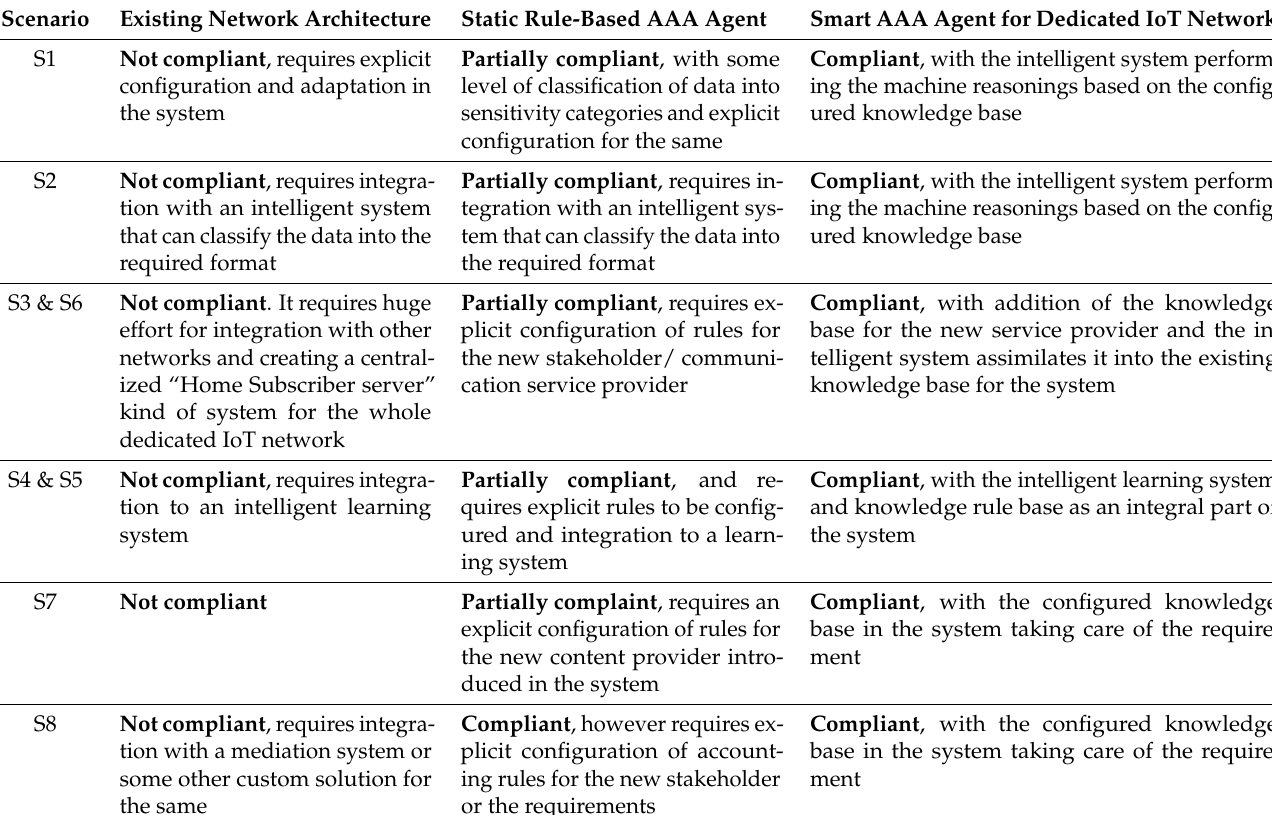
Table 4. Evaluation results and classification based on change